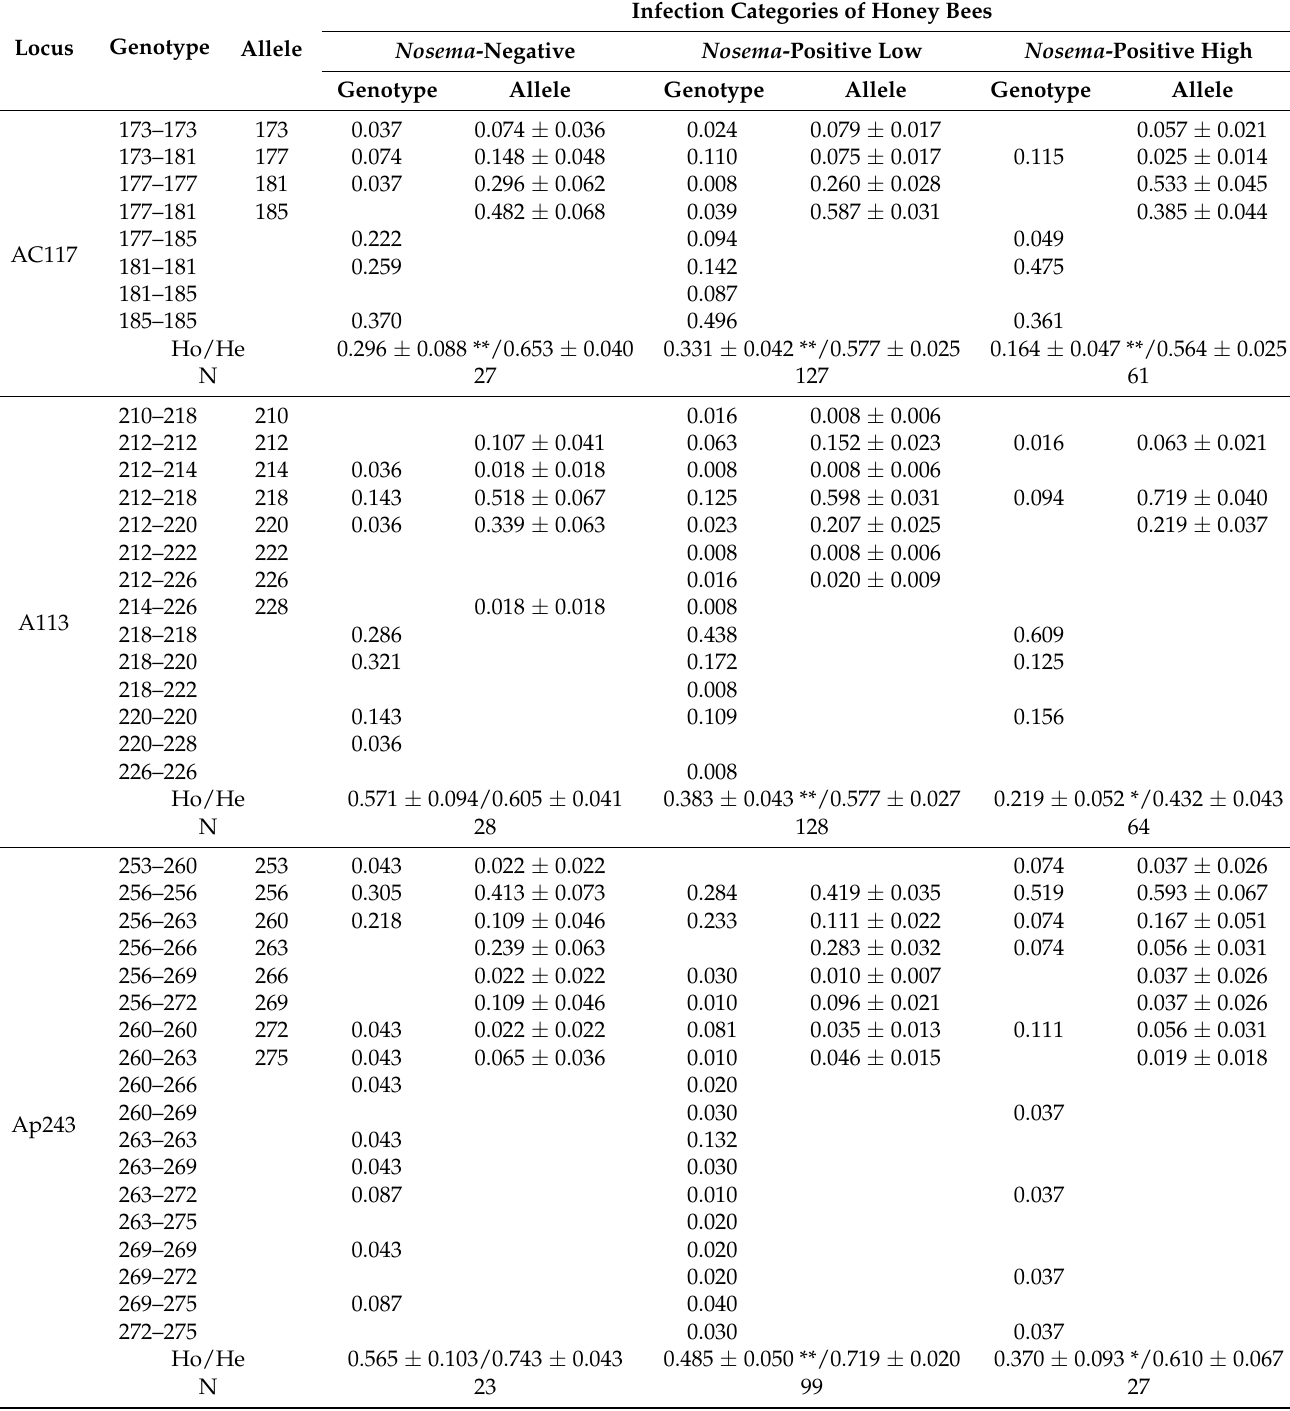
Table 1. Genotype and allele frequencies and heterozygosity at 7 microsatellite loci in the dark forest bees with varying degrees of Nosema